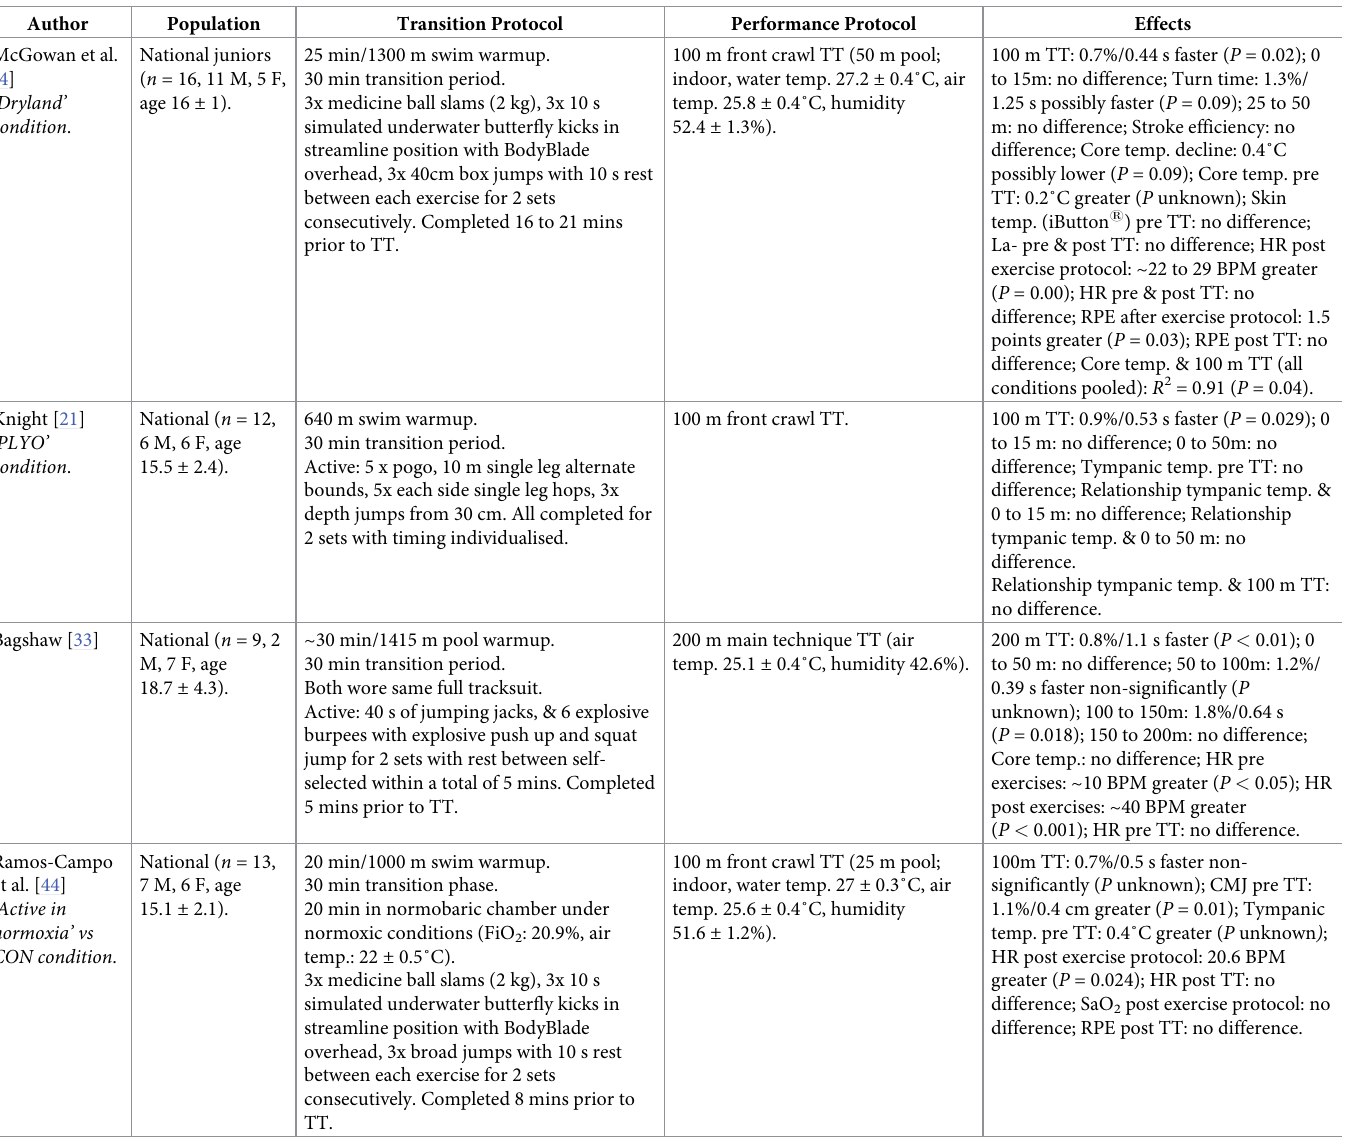
simulated underwater butterfly kicks in streamline position with BodyBlade overhead, 3x broad jumps with 10 s rest between each exercise for 2 sets consecutively. Completed 8 mins prior to